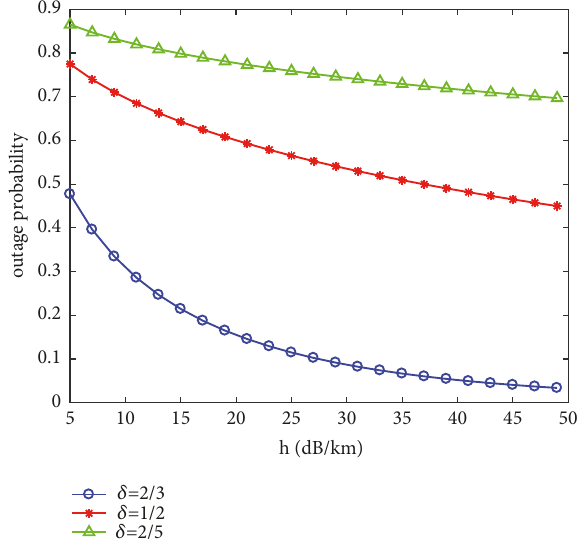
Figure 4: Outage probability versus ℎ (dB/km) for absorption factor.